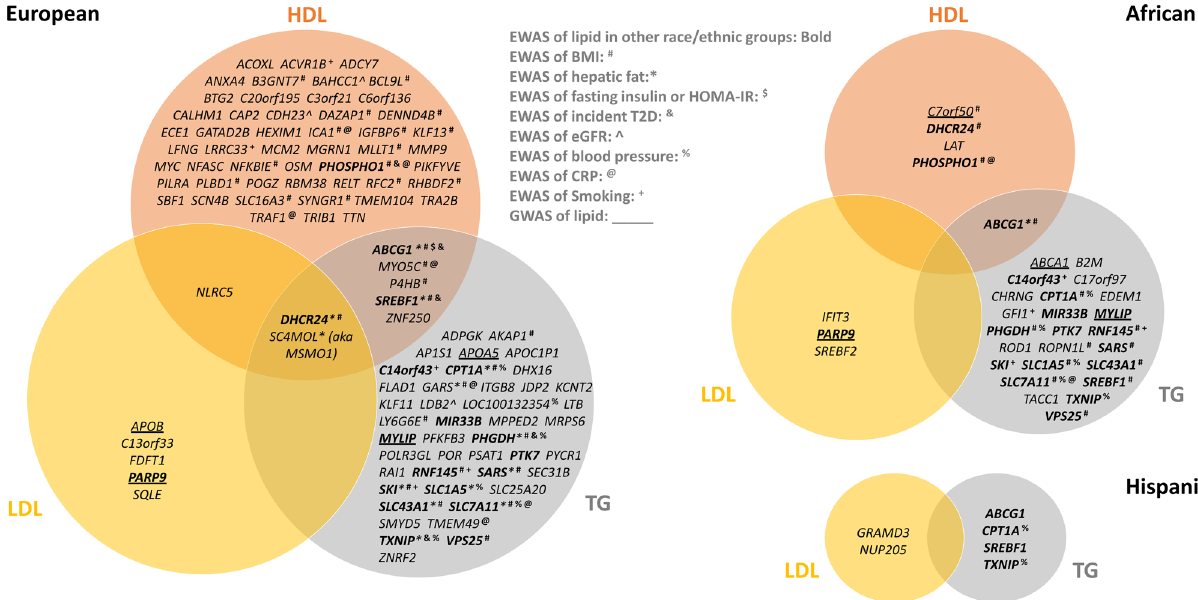
Fig. 3 Venn diagram of genes identi fi ed through epigenome-wide association study of lipids and their overlap with other EWAS as well as genome- wide association studies of lipids. Genes identi fi ed in the racial/ethnic speci fi c (European, African, and Hispanic) strati fi ed meta-analysis of CpG-lipid associations involving either high-density lipoprotein (HDL), low-density lipoprotein (LDL), or triglycerides (TG) levels after adjusting for BMI and excluding subjects on statins. Genes identi fi ed in more than one racial/ethnic population are in bold font. Genes identi fi ed in EWAS of related cardiometabolic traits are marked with special characters: BMI (#), hepatic fat (*), fasting insulin or HOMA-IR ($), incident type2 diabetes (&), eGFR (^), blood pressure (%), C-reactive protein (CRP) (@), and cigarette smoking ( + ). Genes identi fi ed in previous GWAS are